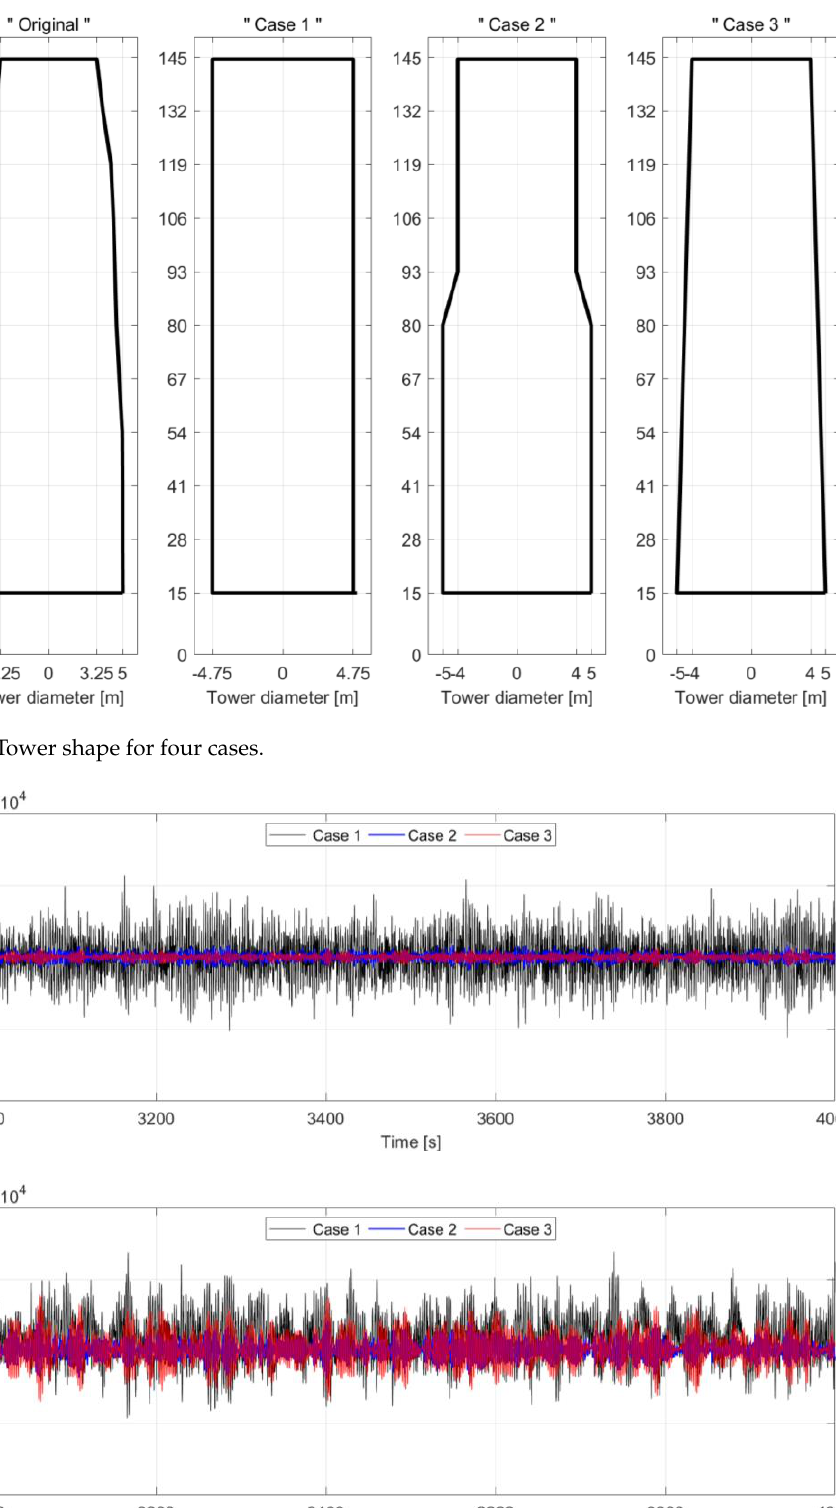
Figure 16. Tower-top and tower- base pitch moments difference from “Original” case . is not significant; case 1 shows a maximum difference of approximately 5,400 kNm. The average of the four cases is approximately 54,000 kNm, and the maximum tower-top pitch